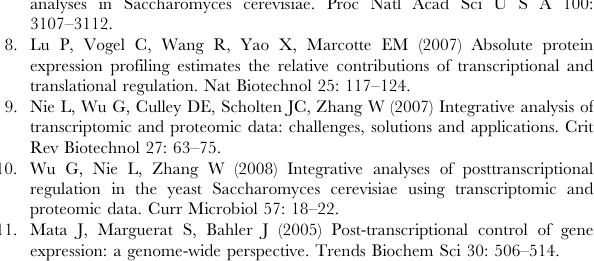
Table S2 Regulatory coefficients calculated between the